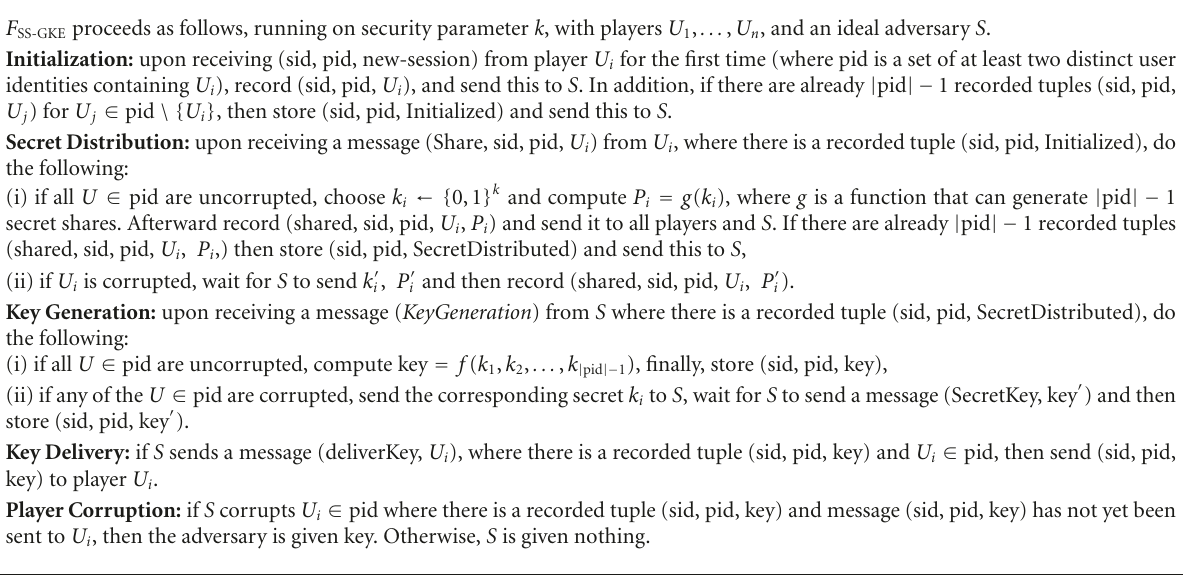
Algorithm 2: AKE → UC